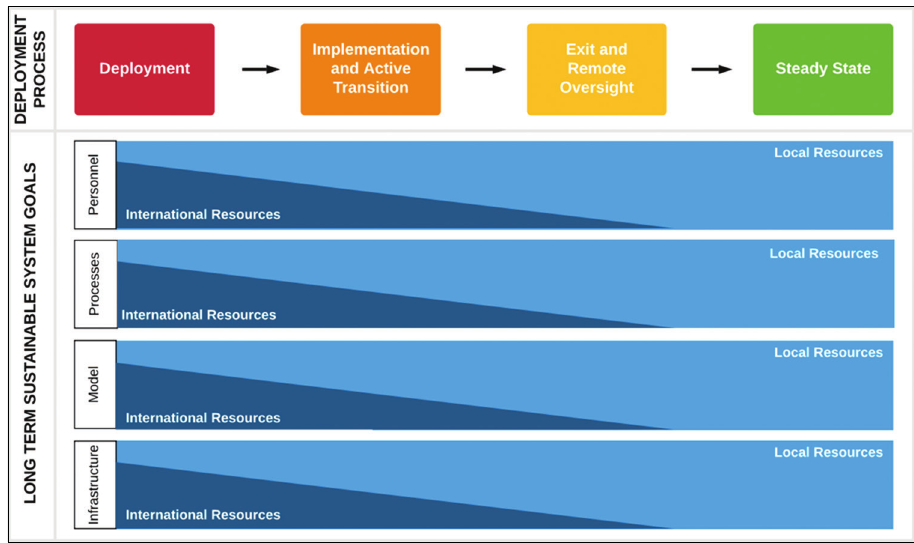
Figure 2: A potential strategy for implementation of a synergistic artificial intelligence driven global health